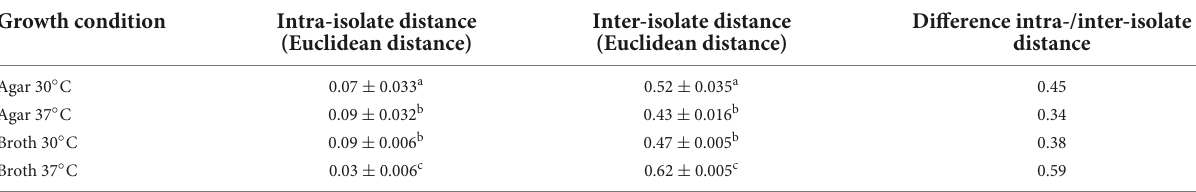
TABLE 1 Assessment of the validity of IR Biotyper R (cid:13) results for scheme